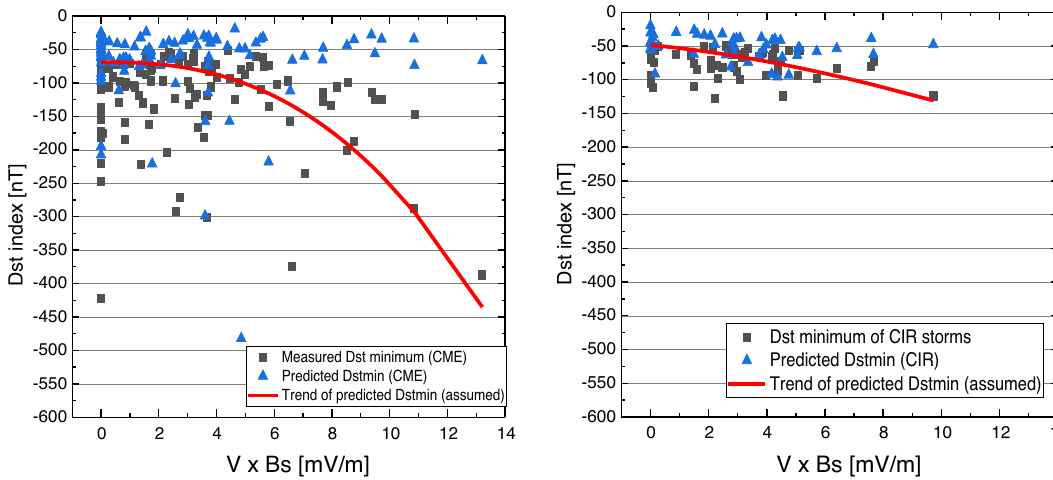
Fig. 3. Predicted minimum Dst (blue) and corresponding measured minimum Dst (black) with respect to V (cid:4) Bs for CME-driven (left) and CIR-driven (right) storms. The red lines show the values calculated from equations (7) and (8) with Bt = Bs , V = 500 km/s, and N = 30/cm 3